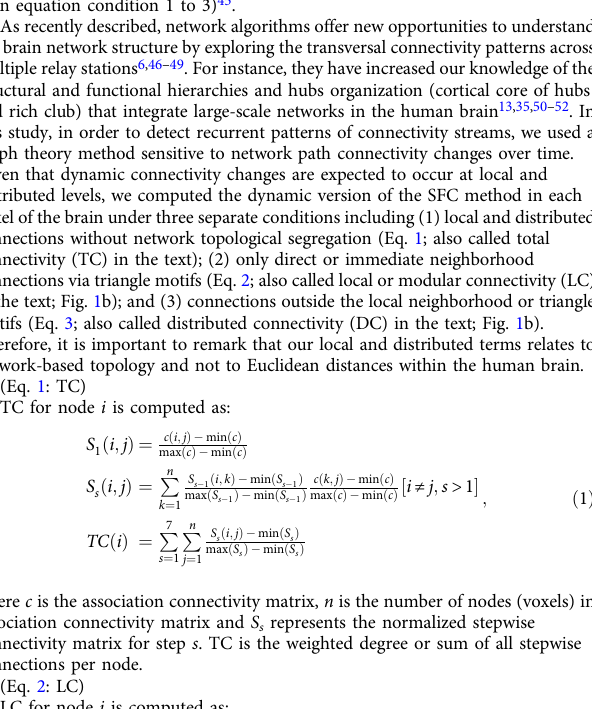
cutoff frequency of 0.01Hz and 0.08 Hz was applied to remove spurious fl uctuations 42,43 (alternative window sizes and high-pass fi lters in Supplementary Fig. 4; static condition, no sliding window approach Supplementary Fig. 5). The Pearson's correlation of the time series of all the voxels in each time window was computed, which generated a functional connectivity matrix for each time window. We used a whole-brain mask — containing cortical gray matter, subcortical struc- tures and cerebellum — of 5138 voxels to extract the BOLD time series and applied the sliding window approach. This step generated a 5138 × 5138 association matrix per sliding window (sliding windows varied between task ranging from 147 to 376). All the connections with negative correlation values or correlation values with a p value less than 0.05 were removed from the functional matrices to eliminate the network links with poor interpretability and low temporal correlation, which are likely to be attributable to noise 44 . Finally, we applied a variance-stabilizing transformation (Fisher's transformation) to all correlation coef fi cients of associa- tion connectivity matrices as a fi nal step before our graph theory-based analysis ( c in equation condition 1 to 3) 45 . As recently described, network algorithms offer new opportunities to understand the brain network structure by exploring the transversal connectivity patterns across multiple relay stations 6,46 – 49 . For instance, they have increased our knowledge of the structural and functional hierarchies and hubs organization (cortical core of hubs and rich club) that integrate large-scale networks in the human brain 13,35,50 – 52 . In this study, in order to detect recurrent patterns of connectivity streams, we used a graph theory method sensitive to network path connectivity changes over time. Given that dynamic connectivity changes are expected to occur at local and distributed levels, we computed the dynamic version of the SFC method in each voxel of the brain under three separate conditions including (1) local and distributed connections without network topological segregation (Eq. 1; also called total connectivity (TC) in the text); (2) only direct or immediate